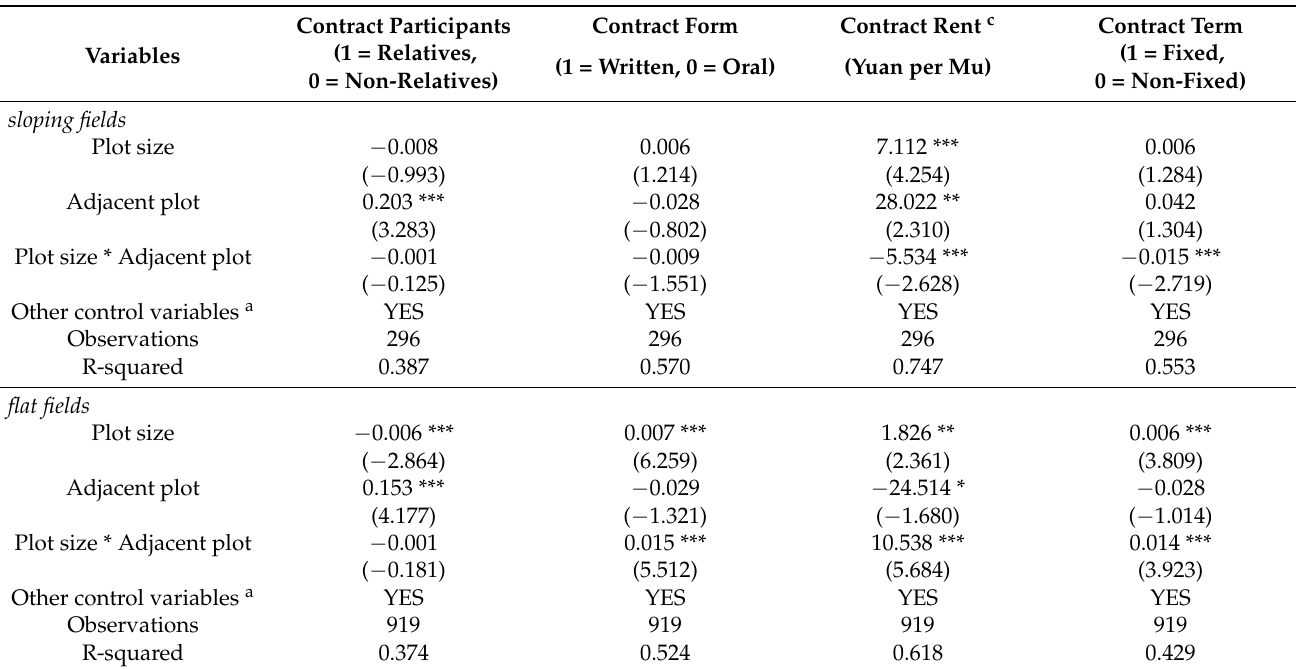
Table 8. The impact of the characteristics of rented-in plots on the contract choice with sloping fields and flat fields, seemingly unrelated